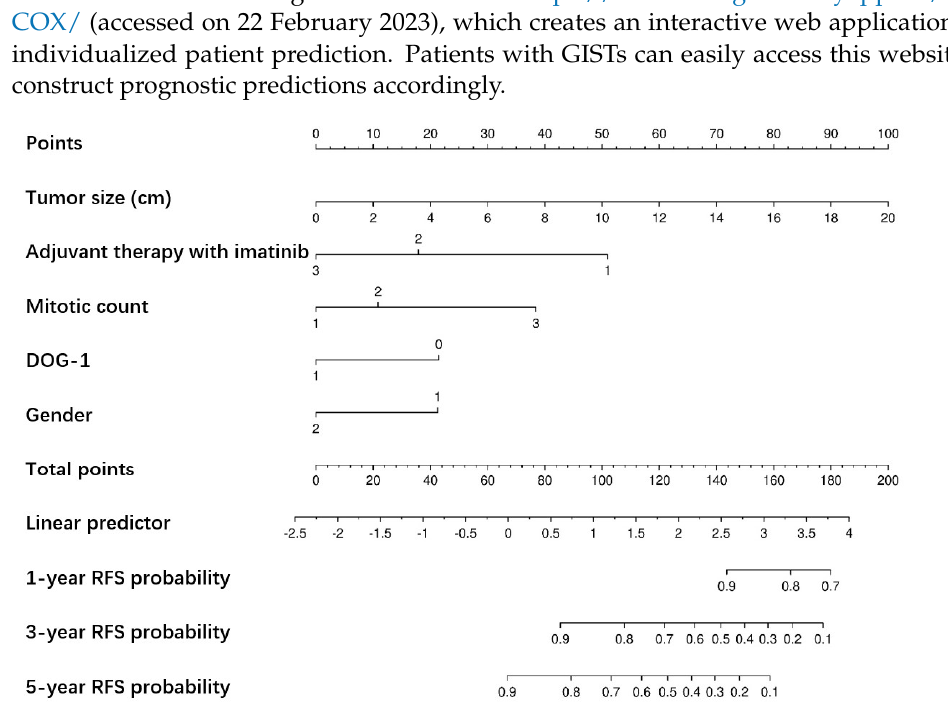
Figure 3. Nomogram predicting the probabilities of 1-, 3-, and 5-year RFS. Points are assigned for tumor size, gender, mitotic count, DOG-1, and adjuvant therapy with imatinib by drawing a line upward from the corresponding values to the “Points” line. The sum of these five points plotted on the “Total Points” line corresponds to predictions of 1-, 3-, and 5-year RFS. Table 2. Univariate and multivariate Cox analysis of prognostic variables in the training set for the RFS of patients with GISTs.